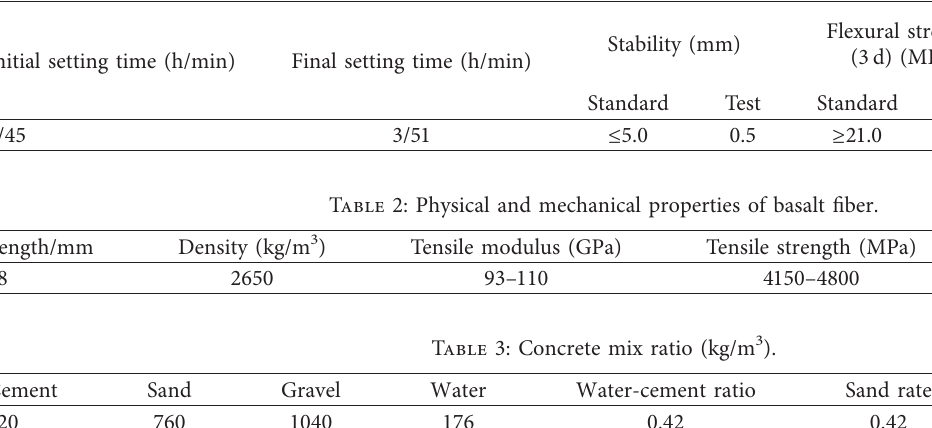
Table 1: Chemical composition and properties of P • O 42.5R cement.